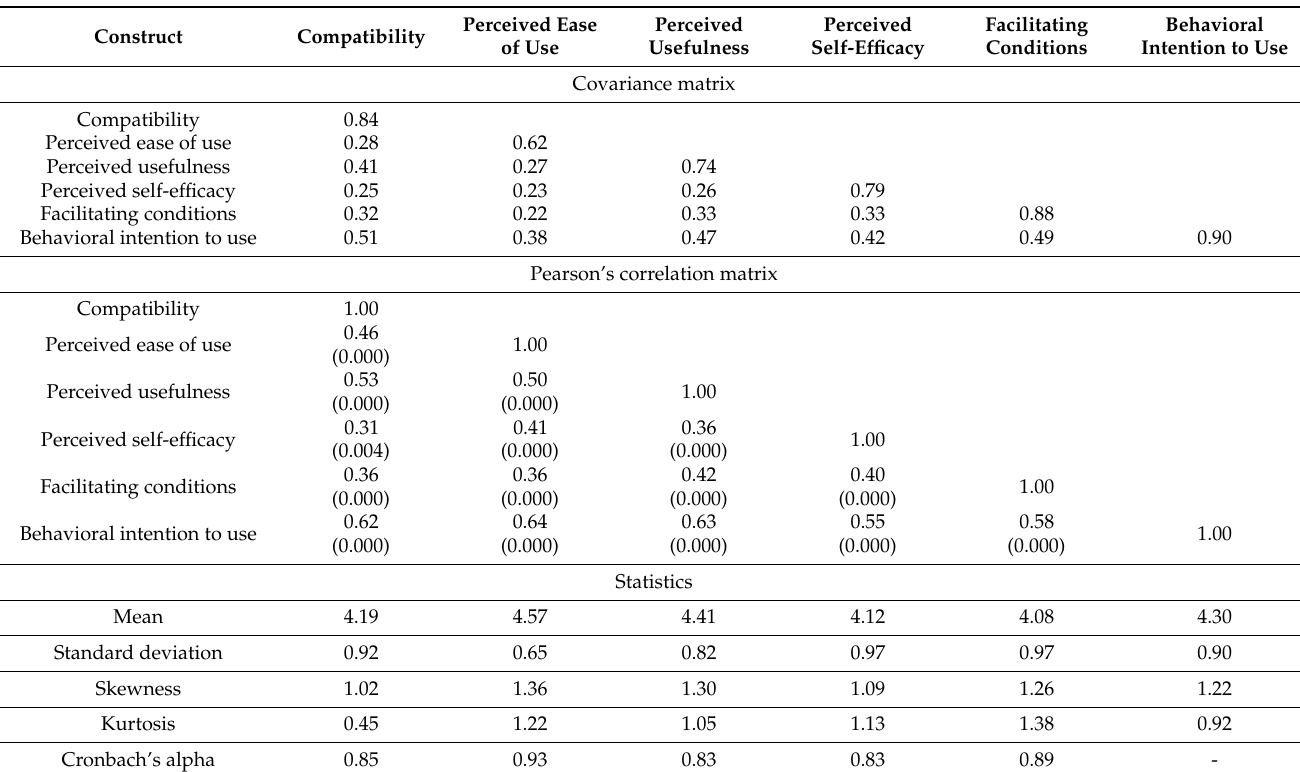
Table 2. Statistical analysis of the data obtained with the measuring